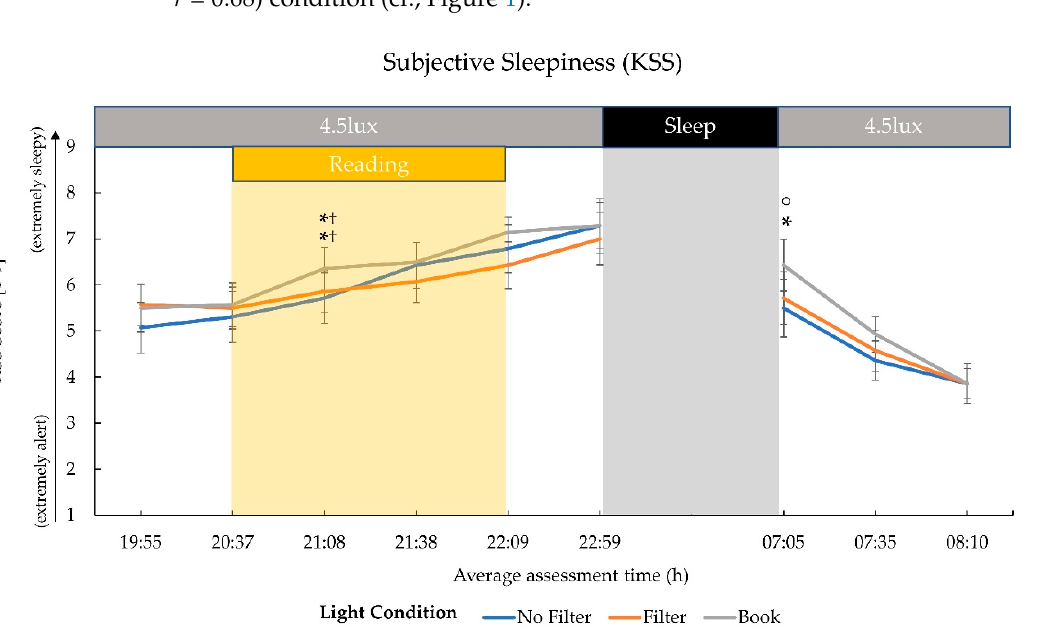
Figure 1. Trajectory of subjective sleepiness ratings (mean and standard error) on the Karolinska Sleepiness Scale (KSS). Administration times averaged over all participants and conditions at the corresponding assessment are shown on the x -axis. The 4.5 lux label corresponds to the background room lighting and refers to photopic lux. During the 8 h sleep interval, lights were switched off (0 lux). Subjective sleepiness was reduced in both smartphone conditions compared to the book condition at 21:08 and 07:05. ◦ = p ≤ 0.10; * = p ≤ 0.05; † = p adj . > 0.10.